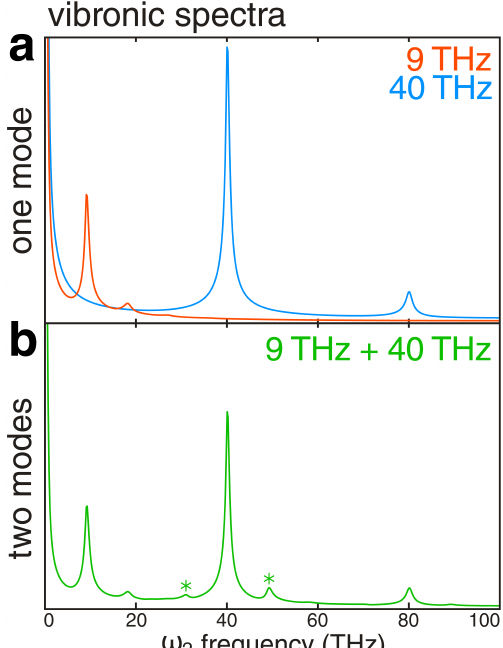
Figure 4. Vibronic spectra showing total amplitude over ω 2 frequencies, obtained from 3D electronic spectra that were Fourier-transformed into the frequency domain. Total vibronic spectra are shown from simulations of ( a ) one mode with frequency ω 0 = 9 THz (red) or 40 THz (blue), and ( b ) two modes with frequencies ω 0 = 9 THz + 40 THz (green), where asterisks label the combination-band peaks at 31 THz and 49